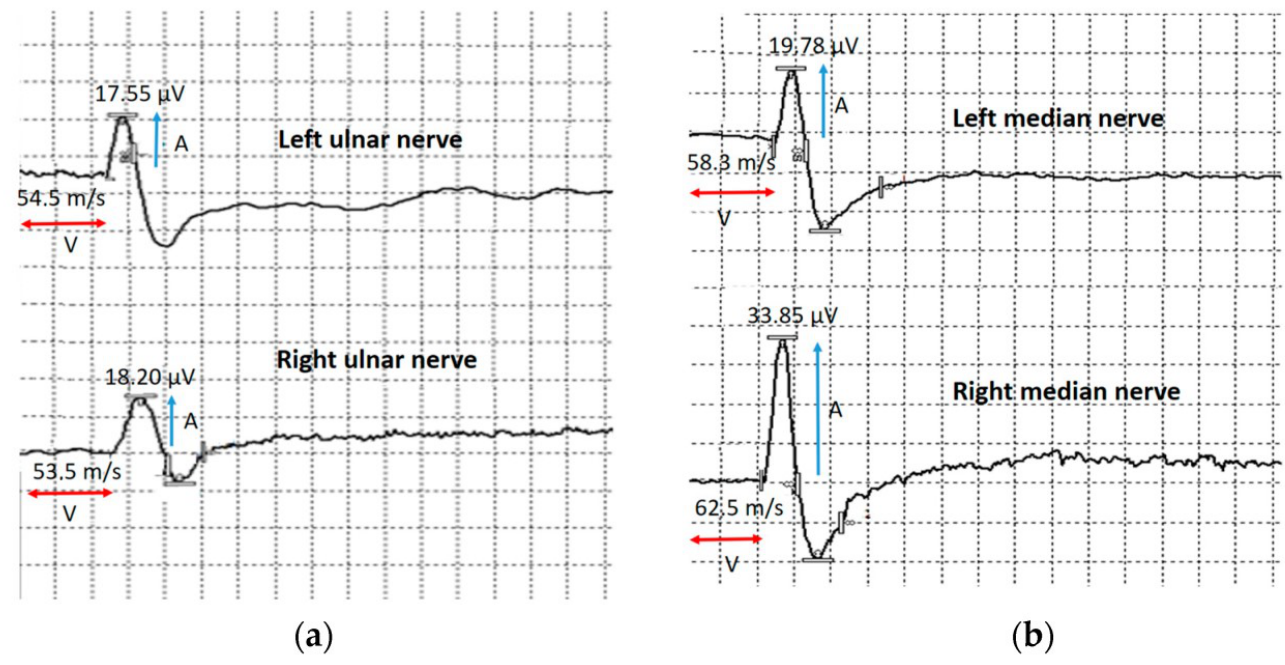
( b ) Figure 8. The motor conduction velocity of the ulnar nerves: ( a ) motor conduction velocity of the left ulnar nerve below the elbow (V1) and above the elbow (V2), and the compound muscle action